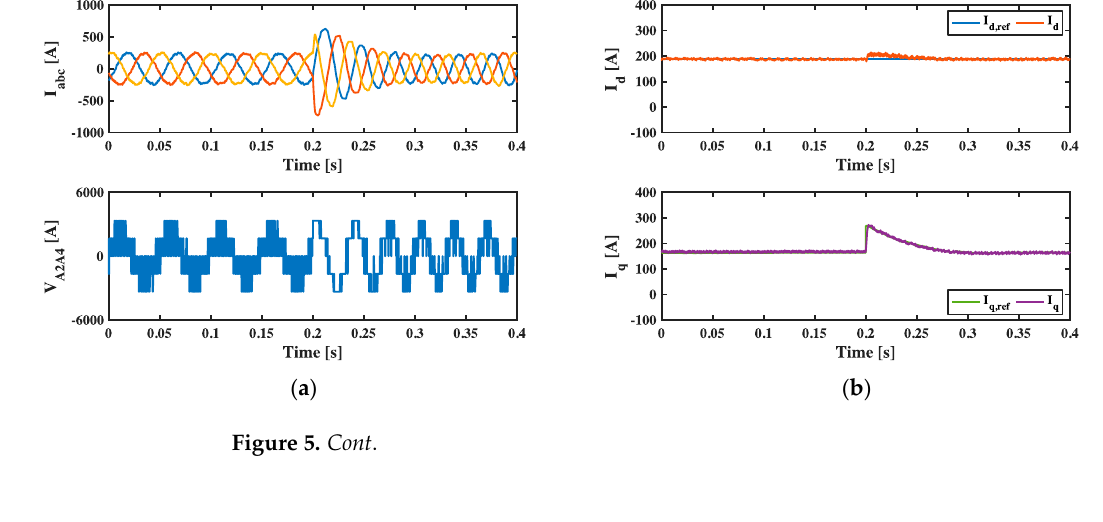
Figure 4. Simulation results for the constant speed and change in the q -axis current. ( a ) Machine currents ( top ) and phase voltage ( bottom ); ( b ) dq -axis currents; ( c ) rotor speed ( top ) and common- mode voltage ( bottom ).